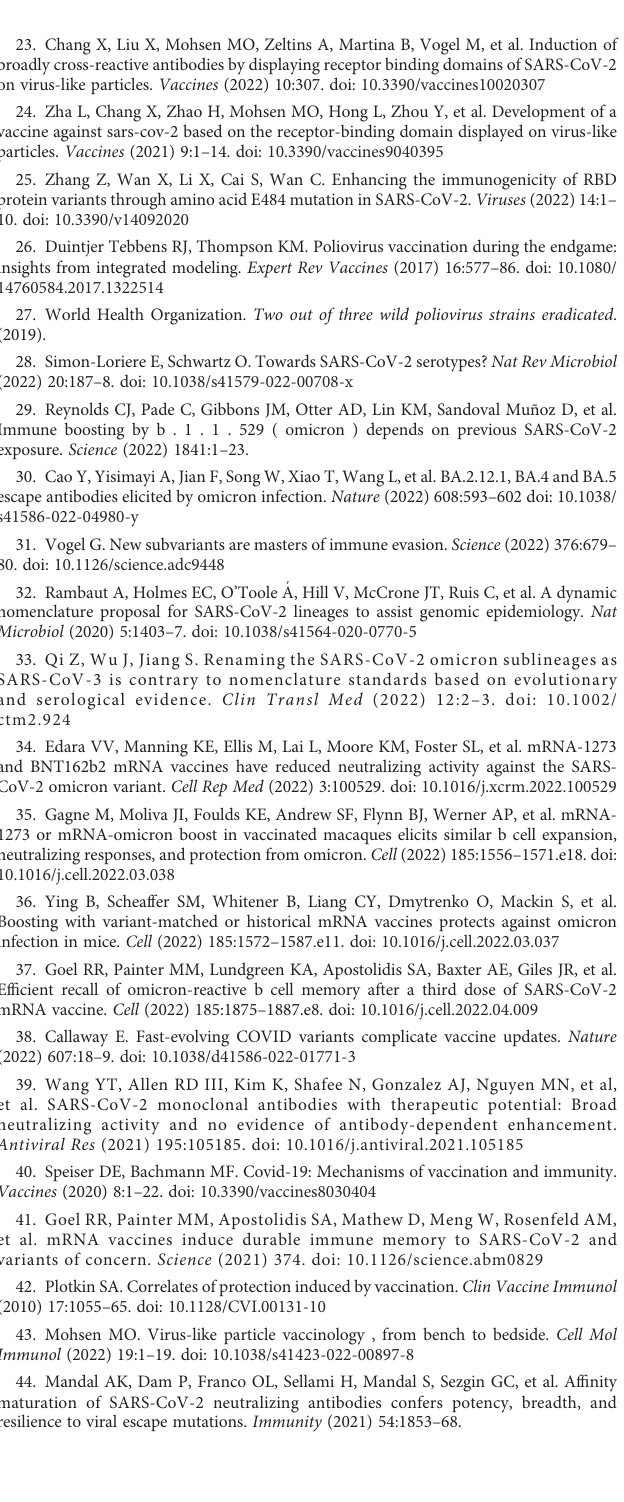
IgG antibody titers on d35 (A) and d42 (B) against RBDs. One-way ANOVA analysis was performed in Prism 9 (n=5), a =0.5 and statistical signi fi cance was displayed as p ≤ 0.05